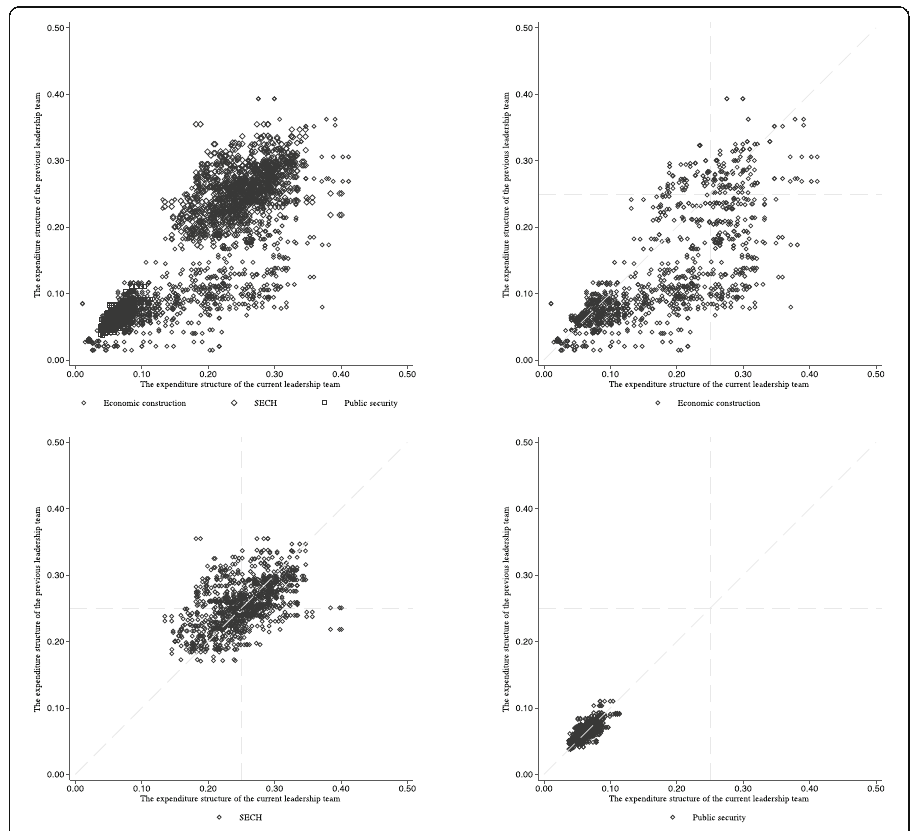
Fig. 3 Scatter diagram of the fiscal expenditure structure of current and former officials (Science, education, culture, and health is abbreviated as